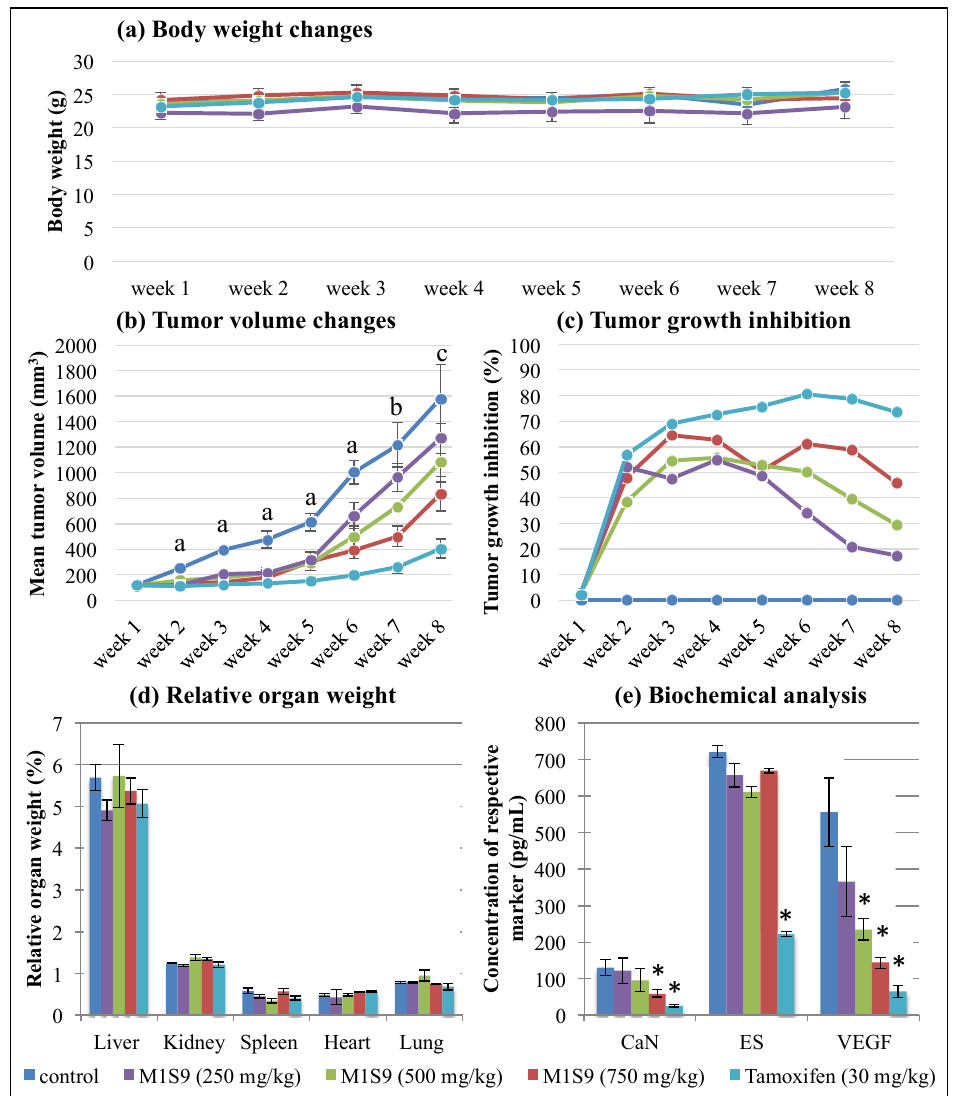
Figure 1. The effects of M1S9 extracts on breast tumor growth using MDA-MB-231 xenograft animal model: ( a ) body weight changes (g); ( b ) tumor volume changes (mm 3 ); ( c ) tumor growth inhibition (%); ( d ) relative organ weight (%); ( e ) biochemical analysis (pg / mL) over eight weeks after treatments with three doses of M1S9 extracts, normal saline (negative control) and tamoxifen 30 mg / kg (positive control). Values are in mean ± S.E.M. In tumor volume changes, a, b and c indicate significant di ff erences ( p < 0.05) with the control at the same week as determined by Dunnett test, a non-parametric test. “a” was significant di ff erence in all treatment groups, “b” was significant di ff erence in all treatment groups except low dose M1S9 (250 mg / kg) and “c” was significant di ff erence in all treatment groups except low dose M1S9 (250 mg / kg) and medium dose M1S9 (500 mg / kg). In biochemical analysis, asterisk (*) means significant di ff erence from control group ( p < 0.05). Abbreviations: CaN—calcineurin; ES—estrogen; VEGF—vascular endothelial cell growth